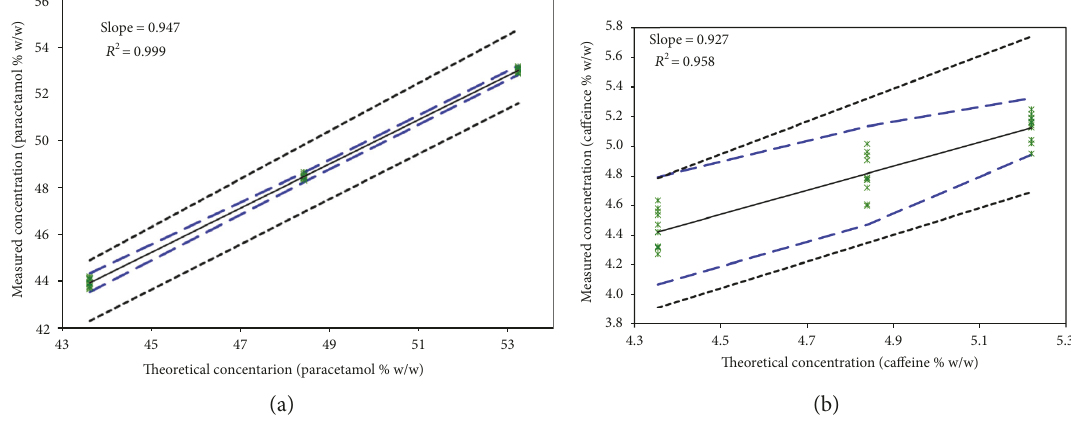
Figure 2: Linearity pro fi le of the NIR — chemometic methods for paracetamol and ca ff eine determination. (a) paracetamol; (b) ca ff eine.